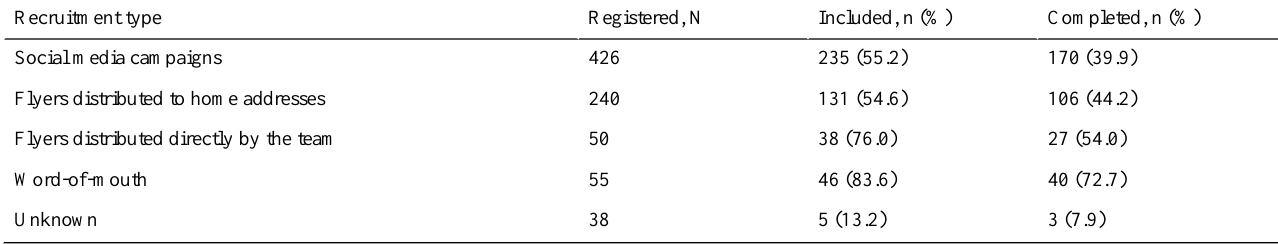
Table 2. The percentage of participants that were included in the study and completed the study compared to those that registered in each recruitment